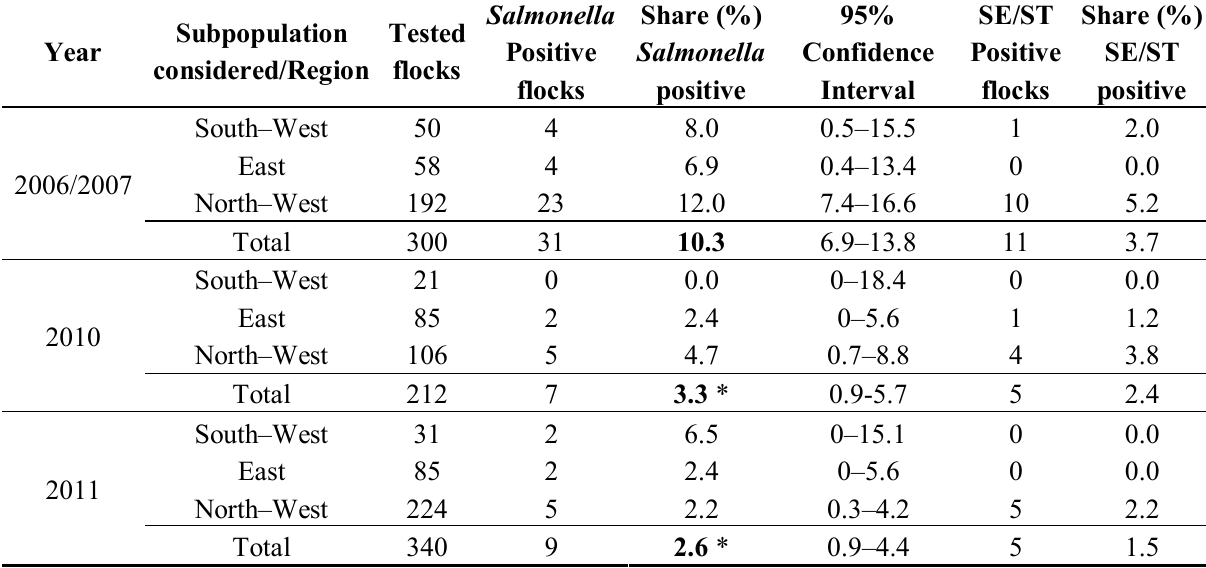
Table 8. Salmonella prevalence in turkey fattening flocks within the control program (official sampling) in comparison to baseline survey